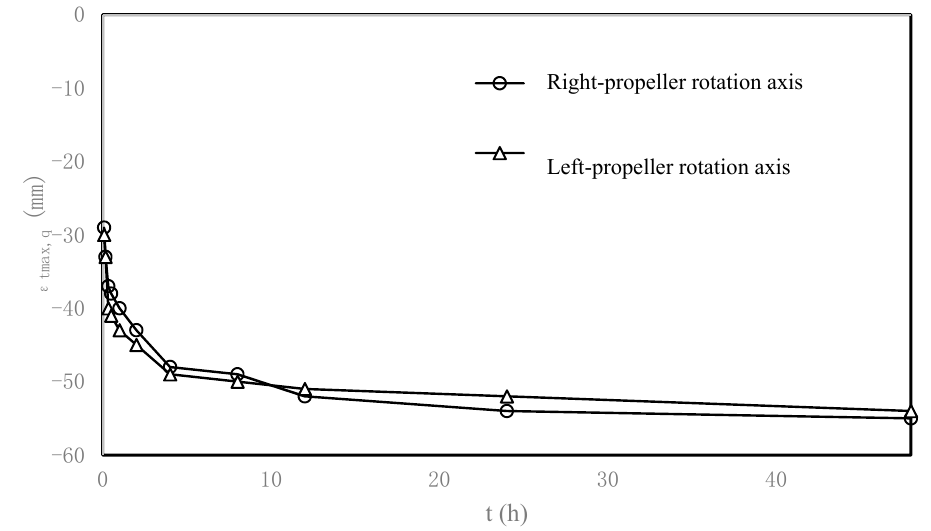
Figure 3. Relationship between temporal scour depth and scour time.